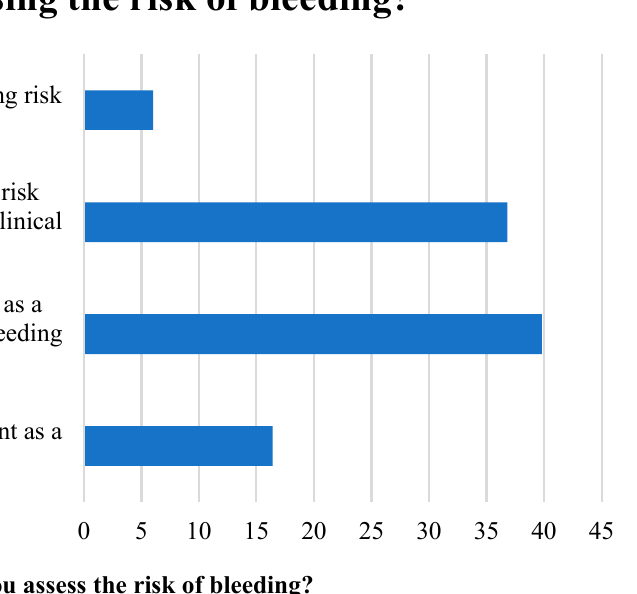
How do you assess the risk of bleeding? Figure 2. Ways of assessing stroke risk by the participants. Figure 2. Ways of assessing stroke risk by the